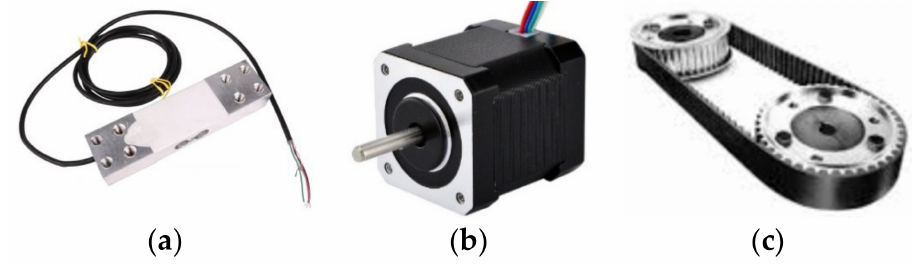
Figure 7. ( a ) 100 kg Load cells measure the reaction force on the hand grips; ( b ) electric step motors power the levers; ( c ) power is transmitted from motors through